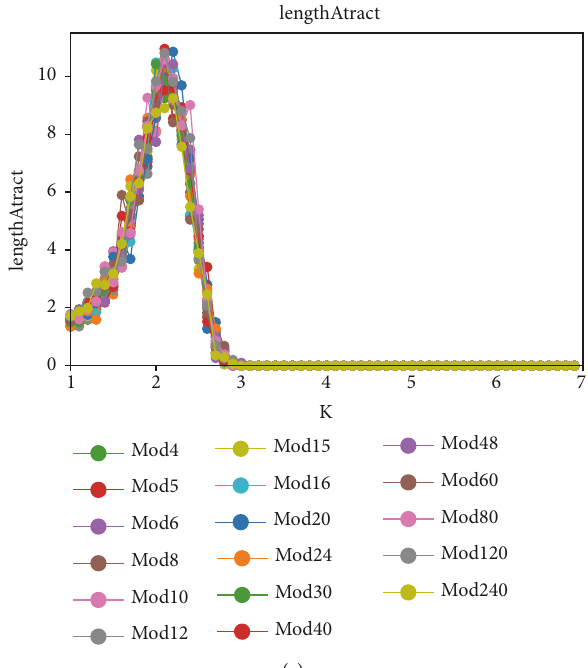
Figure 9: Numbers of attractors, complexity, and lengths of attractors for antimodular RBNs.